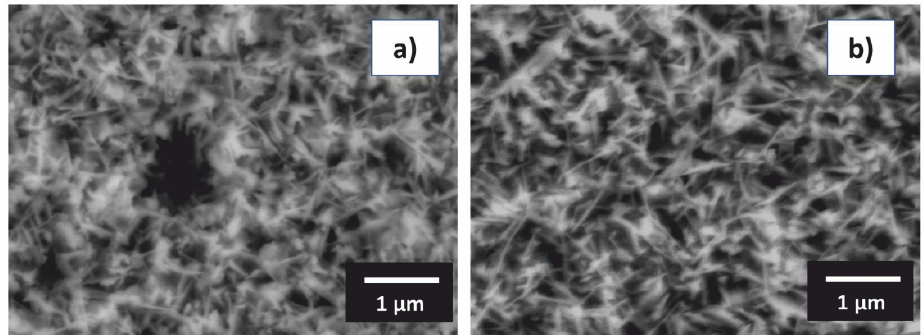
Figure 6. Room temperature XRD patterns of the scales formed on the Al 71 Co 29 and Al 76 Co 24 alloys. For the discussion of the peak marked with an asterisk (*), please refer to the article text.